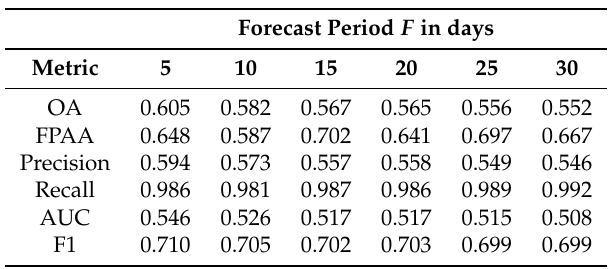
Table 2. Forecast metrics as the forecast period varies in the set F = { 5,10,15,20,25,30 } days. These results are for the OS nonstationary case. Metrics correspond to those reported in Table